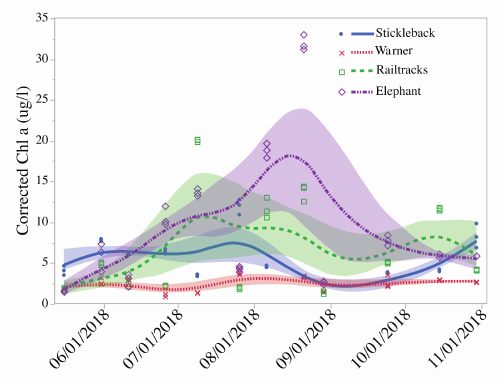
Figure 6. Seasonal variation in phytoplankton biomass, measured as chlorophyll a for four ponds in east-central Minnesota, USA. Fitted curves are cubic splines with a λ of 0.5. Shaded areas are bootstrapped confidence limits of the fitted